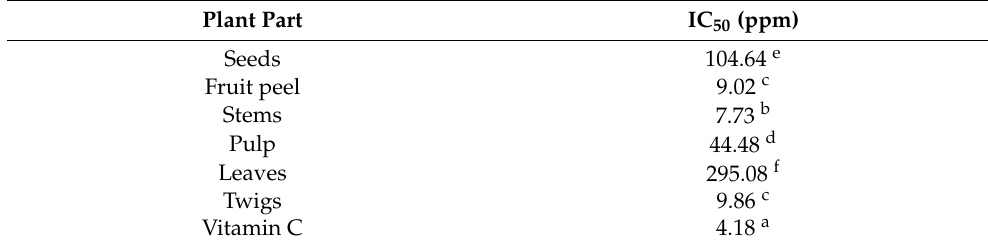
Table 1. Antioxidant activity of X. granatum ethanol